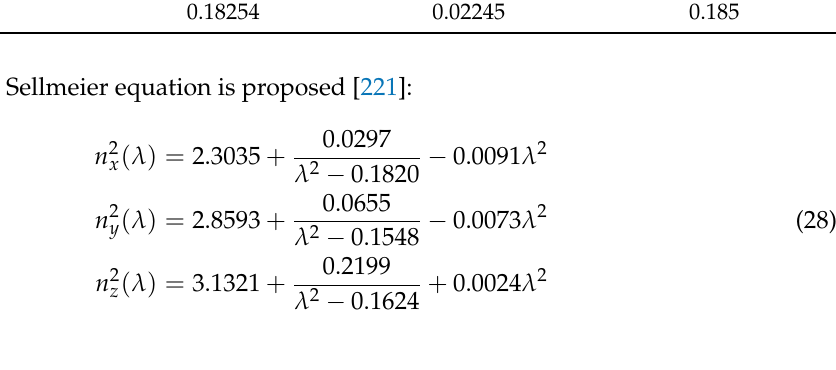
Table 23. NLO coefficients of BNA.